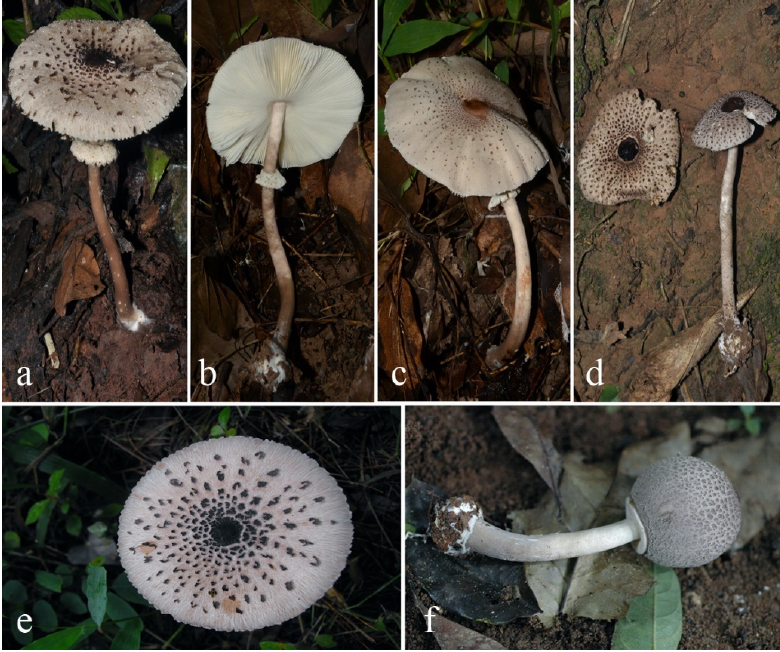
Figure 21. Fresh basidiomata of Macrolepiota velosa in situ. ( a , b ) HNL502655. ( c ) MFLU 09-0052. ( d ) HNL502371. ( e ) MFLU 12-1818. ( f ) MFLU